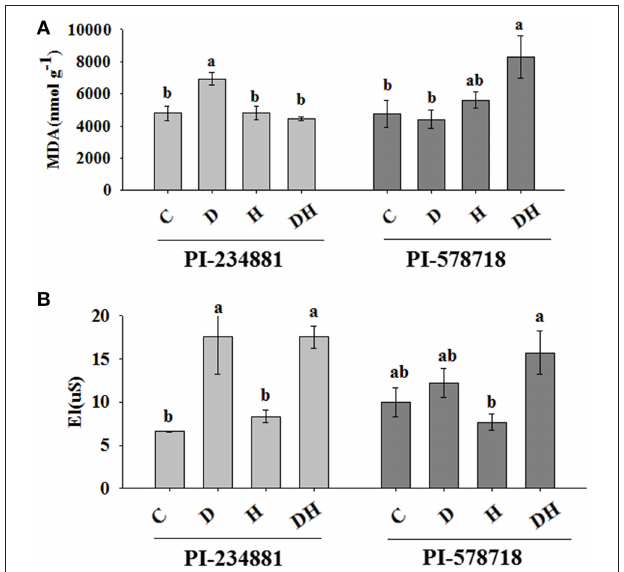
FIGURE 1 | The effects of stress treatments on MDA content (A) and El level (B) in 7th leaves of PI 234881 and PI 578718 under control (C), drought (D), heat (H), combined stress (DH). Different letters indicate significant differences between treatments ( P < 0.05) based on LSD